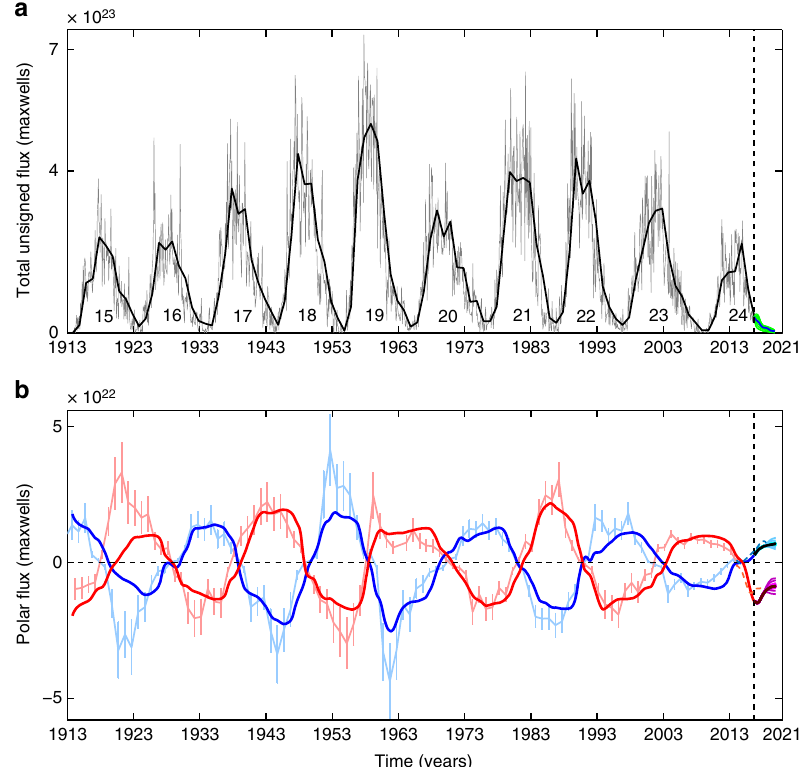
Fig. 2 Data-driven simulation of solar surface polar fl ux. a This panel depicts the evolution of the total unsigned fl ux associated with sunspots which is used to drive the surface fl ux transport model until September 2016 (epoch marked by the dashed vertical line). The gray and solid black curves represent monthly and annually averaged unsigned fl ux, respectively. The blue and set of green curves beyond September 2016 depicts different realizations of the modeled descending phase of cycle 24 used as synthetic inputs to forward run the surface fl ux transport model. b Time evolution of polar fl ux calculated from our surface fl ux transport simulation is compared with those obtained from polar faculae observations. The light blue (and light red) curve with error bars represents the polar fl ux estimated from polar faculae observations in the northern (and the southern) hemisphere, whereas the solid blue (and red) curve shows the polar fl ux obtained from our simulation for corresponding hemispheres. The dashed blue (and dashed red) curve beyond 2014.5 represents the polar fl ux obtained from WSO polar fi eld observations for the northern (and the southern) hemisphere. The set of light and dark cyan and magenta curves beyond September 2016 (vertical dashed line) depict predicted polar fl uxes (up to 2020) from ensemble runs with varying input fl uxes and tilt angle fl uctuations, respectively. The black and dark red curves represent the polar fi eld prediction from our standard